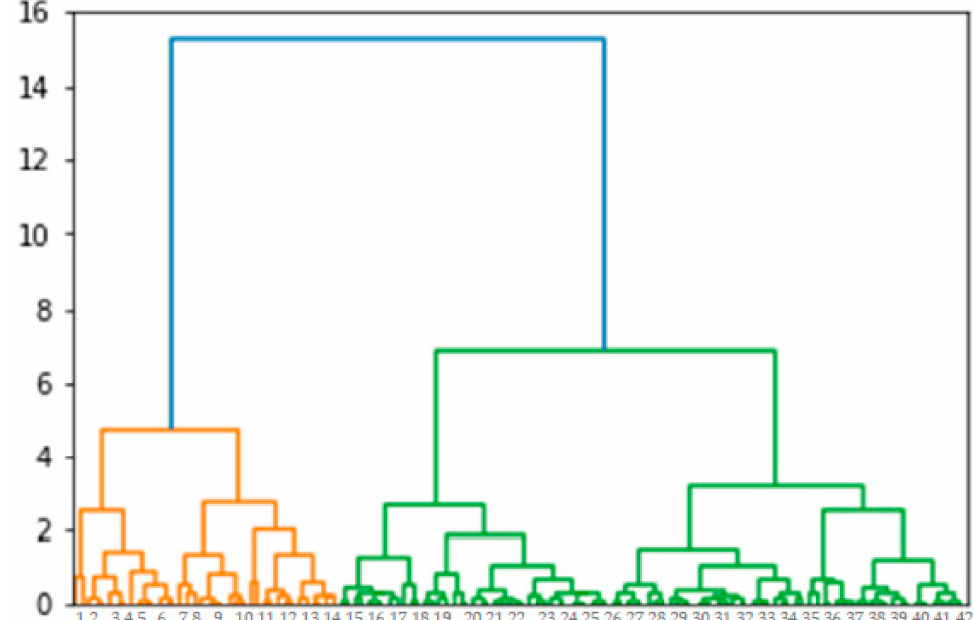
Figure 4. A dendrogram of clustering risk